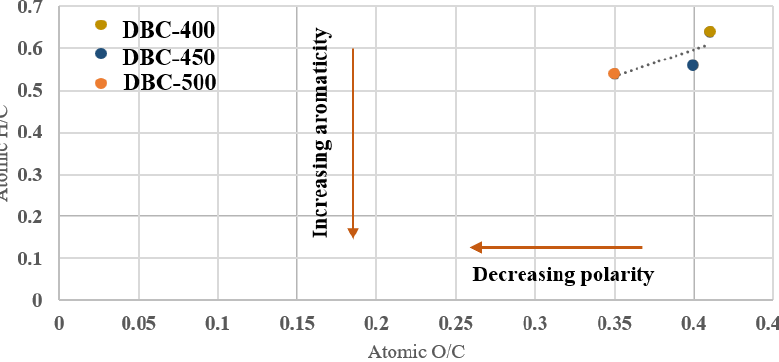
Figure 3. Van-Krevelen diagram of DBC biochar obtained from different pyrolysis temperature.